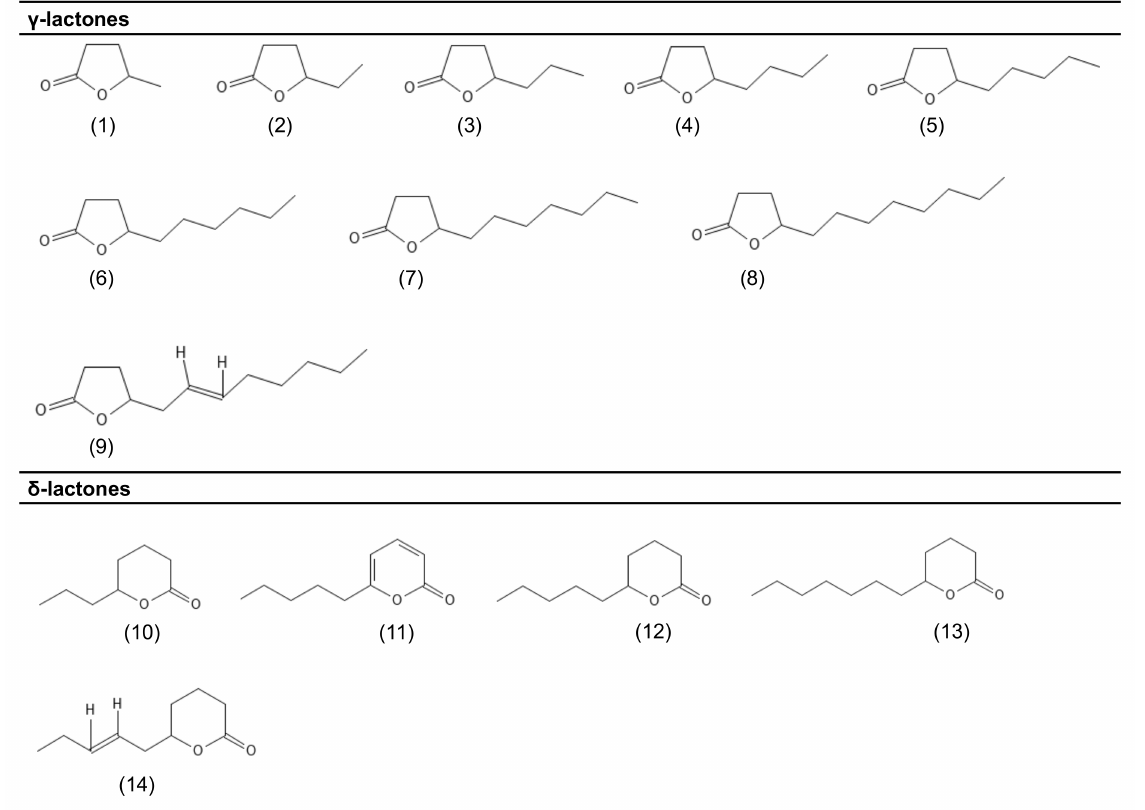
Figure 1. Chemical structures of different γ -lactones and δ -lactones produced by microbial de novo biosynthesis. Numbers refer to Table 1, where these lactones are identified and their main properties